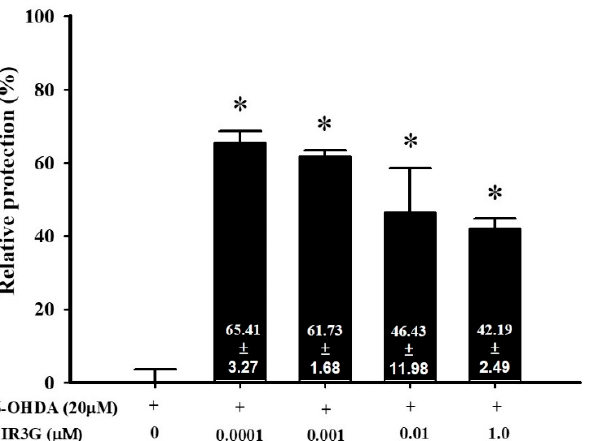
Figure 3. Anti ‐ inflammatory activity of IR3G. Dexamethasone (DEX) was used as the positive con ‐ trol at 10 μ M, inhibiting COX ‐ 2 and iNOS expressions from 100% in the LPS ‐ stimulated cells to 15.97 ± 2.50% and 29.34 ± 6.34%, respectively. The values are mean ± S.E.M. ( n = 6). *,Significantly different from LPS ‐ activated group ( p < 0.05).